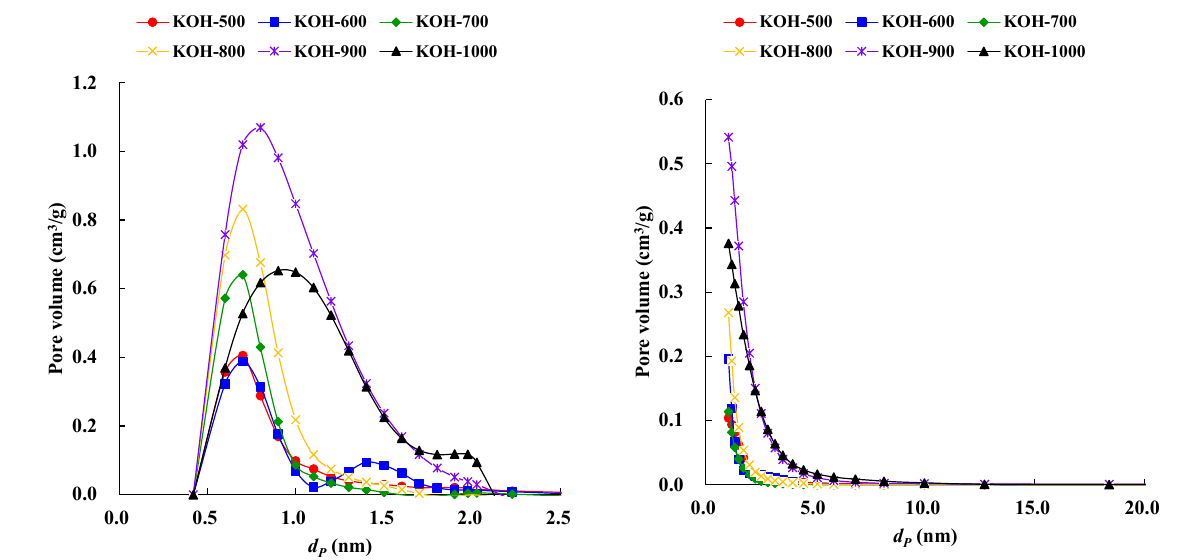
Figure 5. Micropore and mesopore distribution of KOH activated carbon prepared at different tem- peratures.